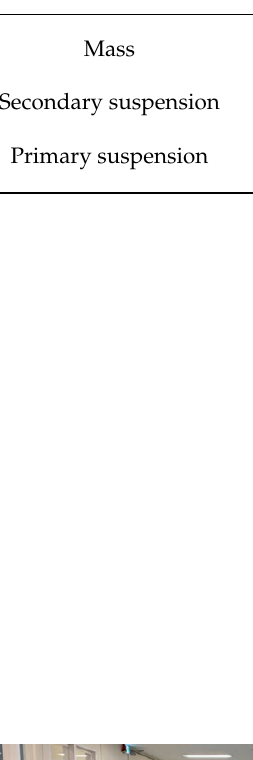
( b ) Figure 4. Stewart platform: ( a ) configurations, ( b ) linear electromagnetic actuator. Table 2. Details of the Stewart platform. Items